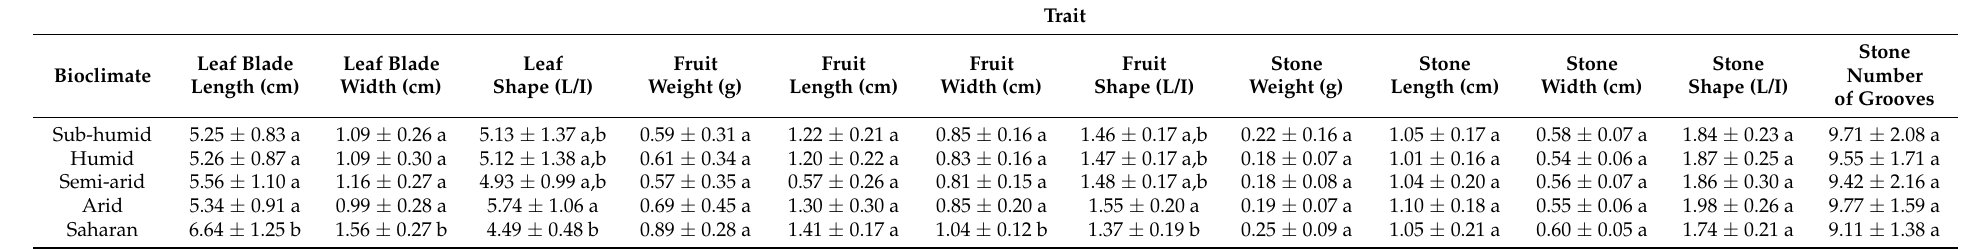
Table 4. Descriptive statistics with average ± standard deviation for each of the 12 quantitative morphological traits in each bioclimatic area. Different letters indicate significant difference ( p <